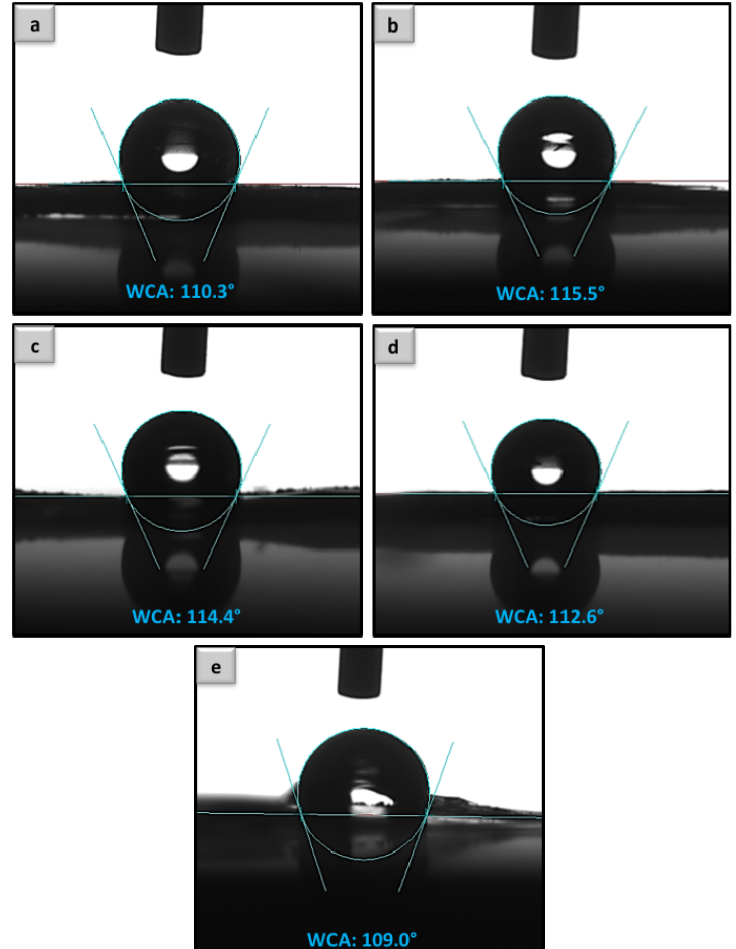
Figure A2. Representative water ‐ in ‐ air contact angle droplet images: ( a ) uncoated PHBV; ( b ) PMMA; ( c ) Comp.(9:1); ( d ) Comp.(7:3); and ( e ) Comp.(5:5).